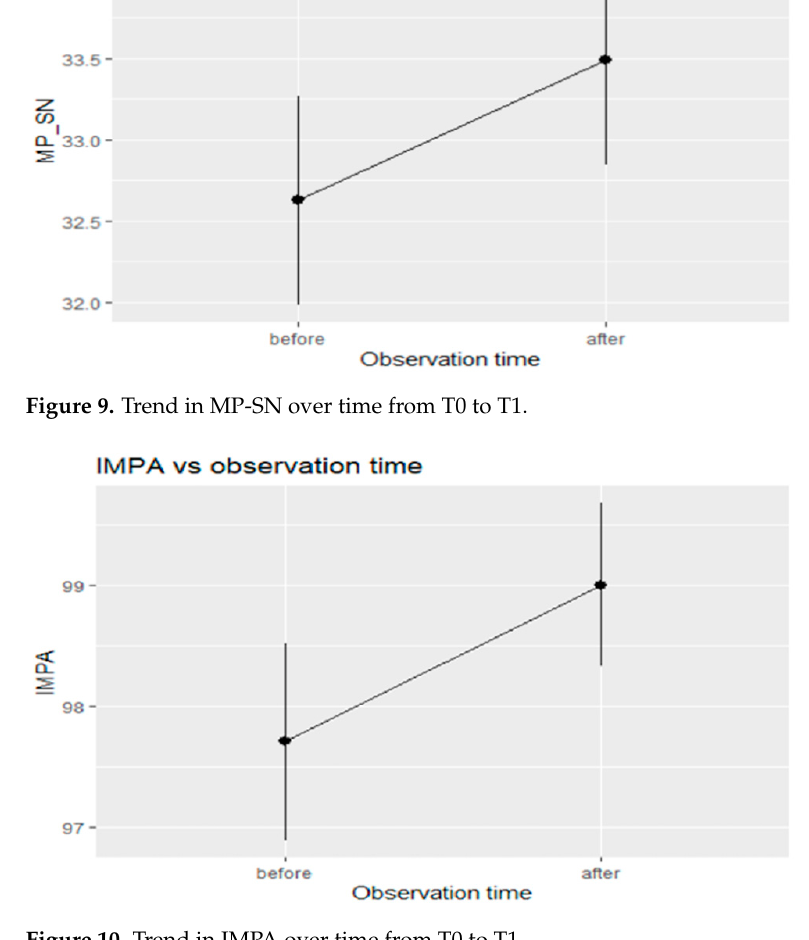
Figure 10. Trend in IMPA over time from T0 to T1.